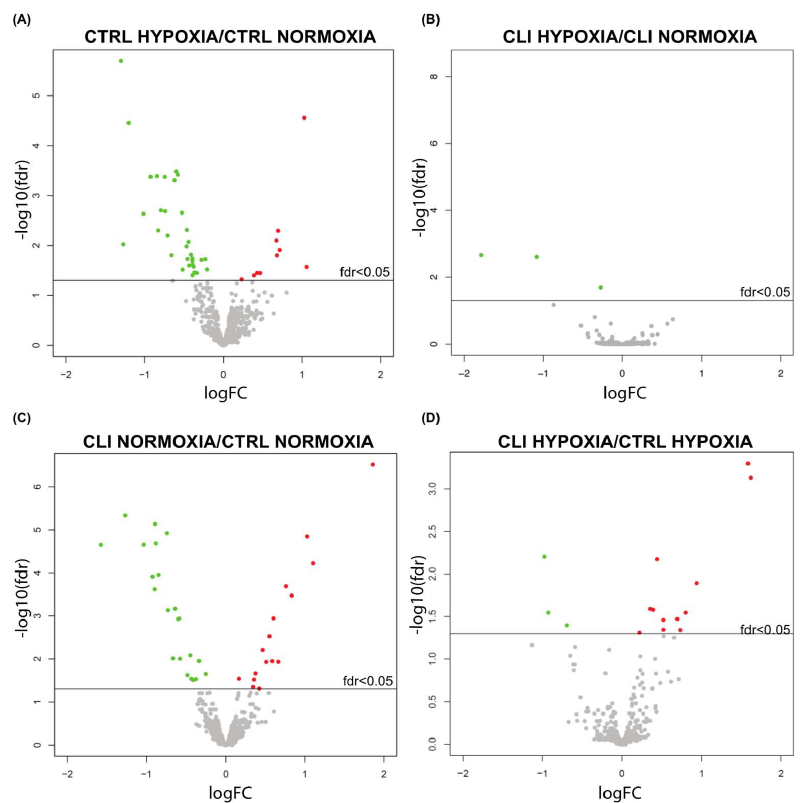
Figure 1. Volcano plots representing differentially expressed miRNAs (statistical significance vs. differential regulation) in our experimental settings. Significantly up- and down-regulated miRNAs (FDR <0.05) are displayed as red and green dots, respectively, and unchanged miRNAs as grey dots. ( A ) CTRL HYPOXIA/CTRL NORMOXIA; ( B ) CLI HYPOXIA/CLI NORMOXIA; ( C ) CLI NORMOXIA/CTRL NORMOXIA; ( D ) CLI HYPOXIA/CTRL HYPOXIA.